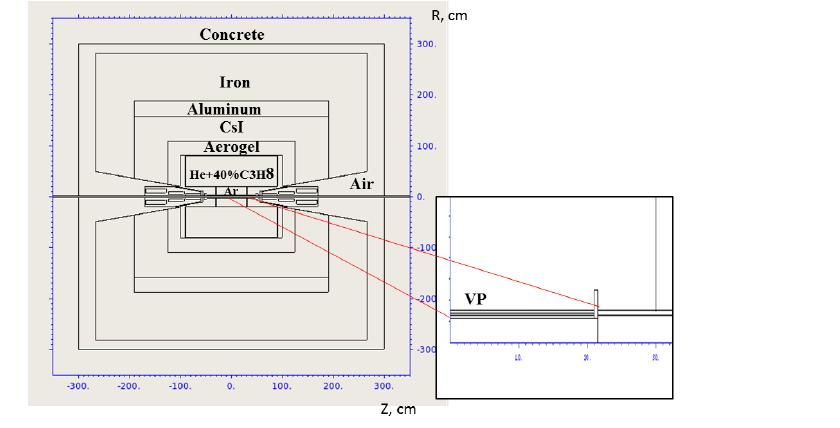
Figure 2. SCTD model in